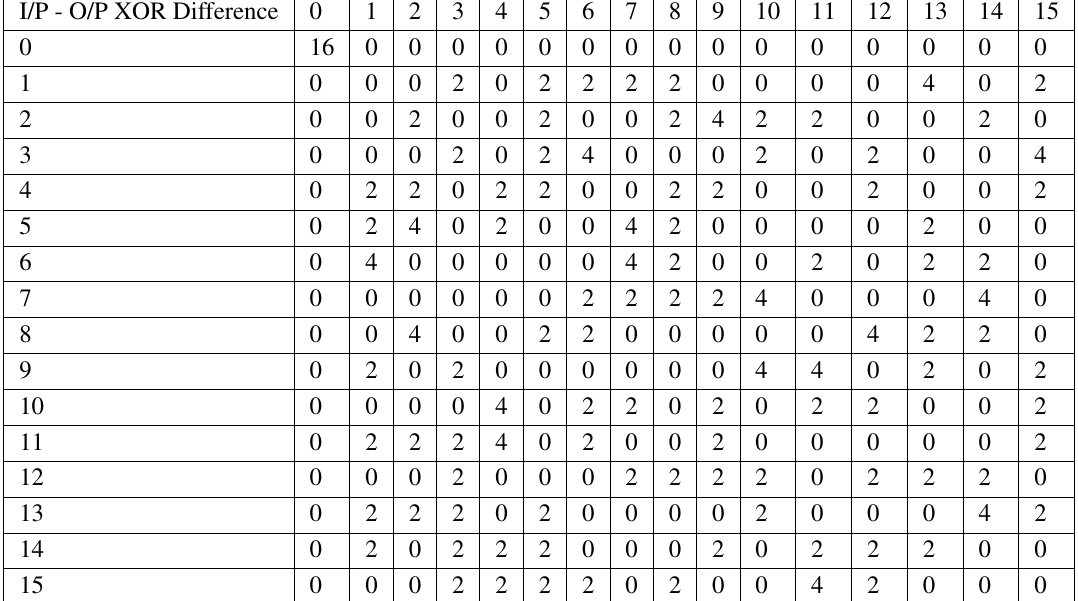
Table 3. The differential distribution (XOR distribution) of S1 (S3 of new GOST S-box) I/P - O/P XOR Difference